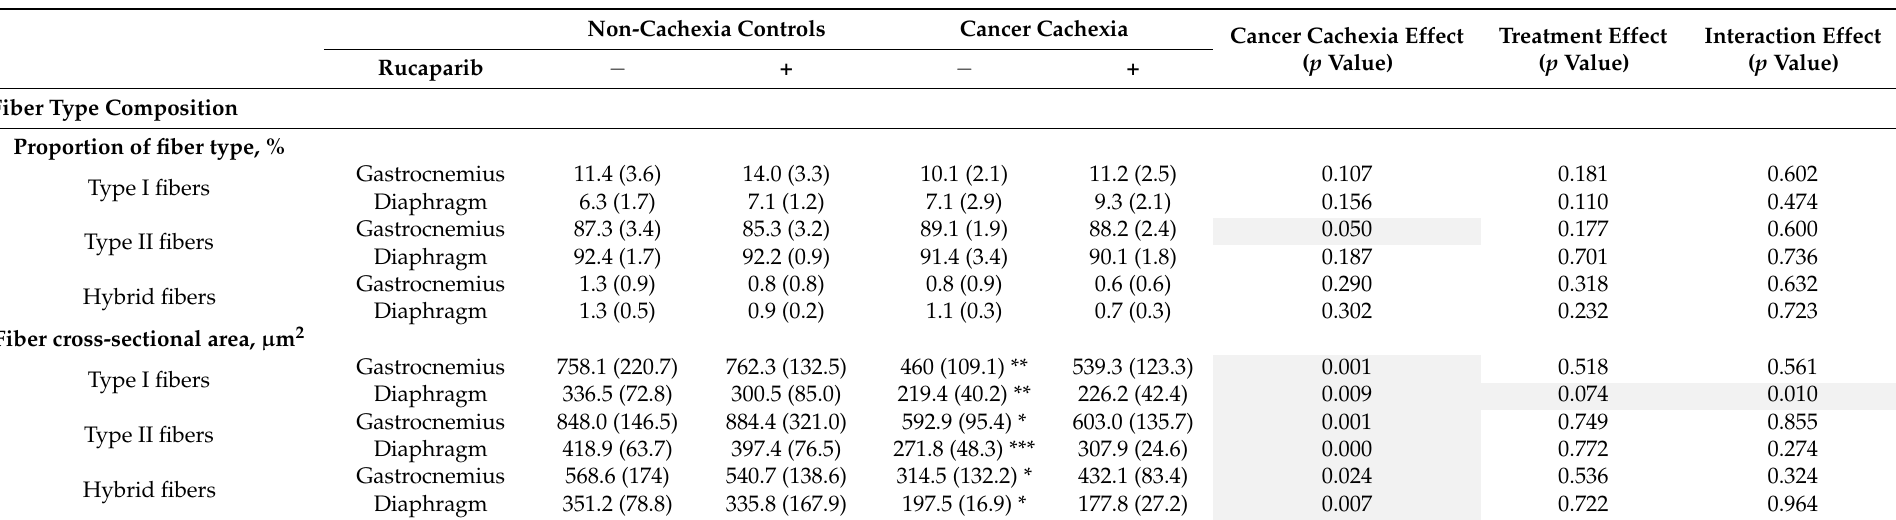
Table 2. Muscle fiber morphometric features of the gastrocnemius and diaphragm muscles in the experimental